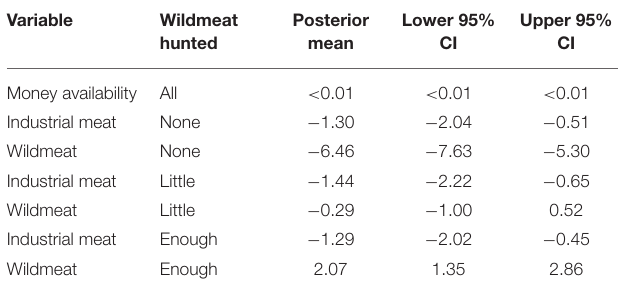
TABLE 4 | We report the posterior mean and the 95% credible interval for the consumption model.